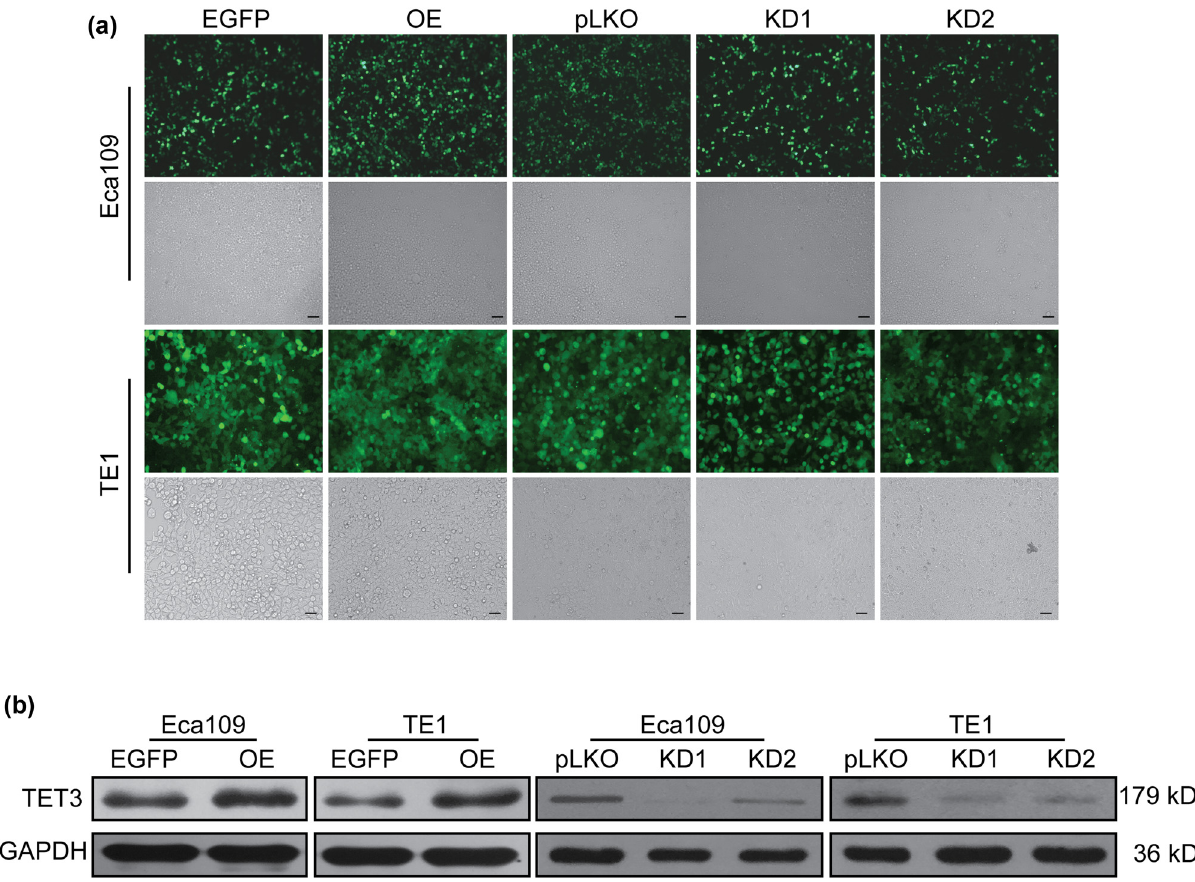
Figure A2: TET3 is over - expressed in ESCA and is correlated to poor prognosis and survival. ( a ) TET3 mRNA is up - regulated in ESCA samples ( TCGA data ) . ( b ) Survival analysis suggested that elevated TET3 resulting in shorter overall